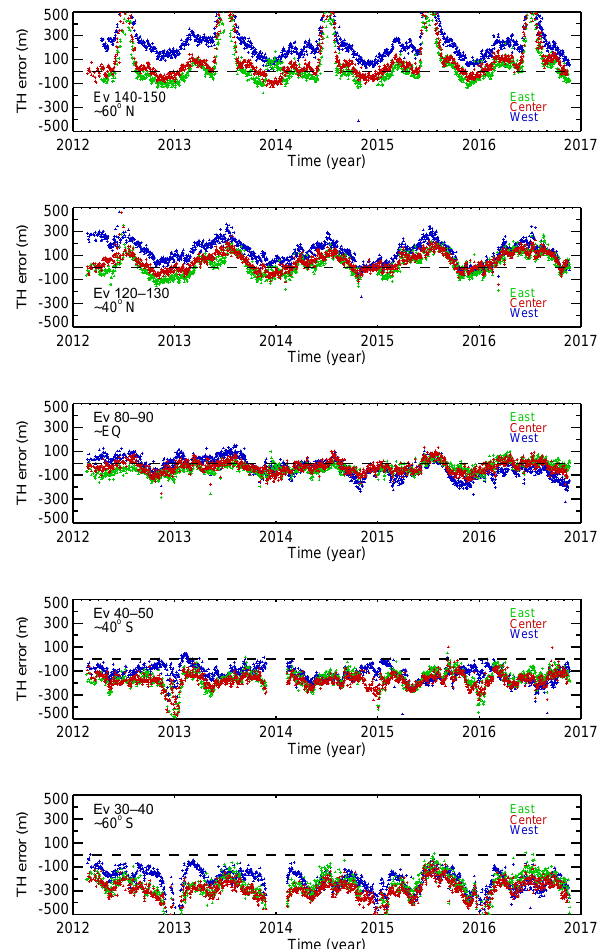
Figure 10. Daily averaged time-dependent plots of TH errors from ARRM analysis for the three slits. Approximate latitudes of the 10- event band averages are noted. Values are normalized (by ∼ 200m) to the Equator just prior to the Kelud eruption on 14 February 2014 based on the RSAS results summarized in Table 1. Slit discrepan- cies and seasonal dependencies of ± 200m can also be seen.